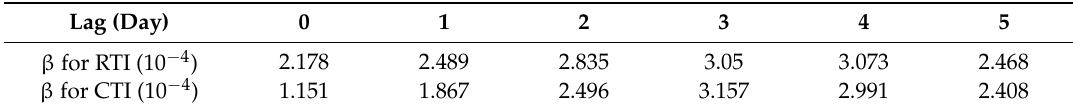
Table 5. The results with the generalized additive model (GAM) taking into account different time lags. Lags of 0–5 days were considered and the corresponding β s for RTI and CTI were calculated. Lag (Day) 0 1 2 3 4 5 β for RTI (10 − 4 ) β for CTI (10 − 4 )